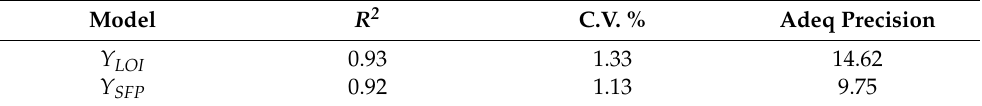
Table 7. Response surface fitting statistical analysis of flame retardant